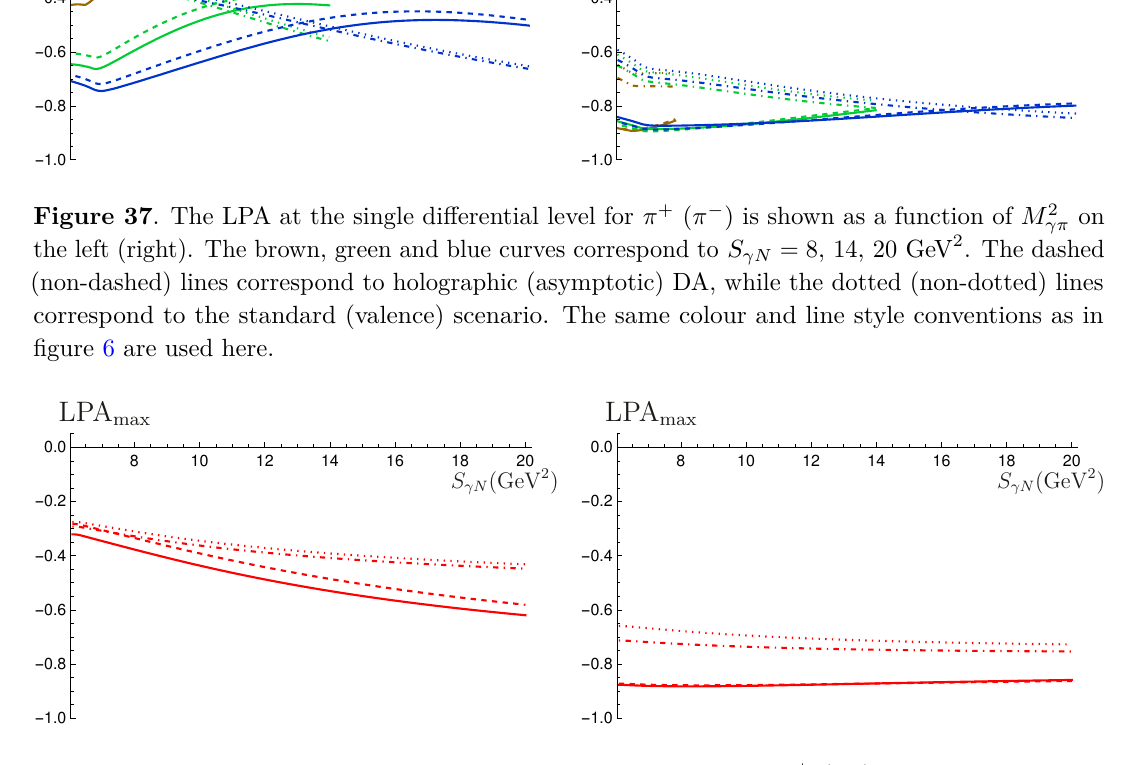
Figure 38 . The LPA integrated over all differential variables for π + ( π − ) is shown on the left (right). The dashed (non-dashed) lines correspond to holographic (asymptotic) DA, while the dotted (non-dotted) lines correspond to the standard (valence)